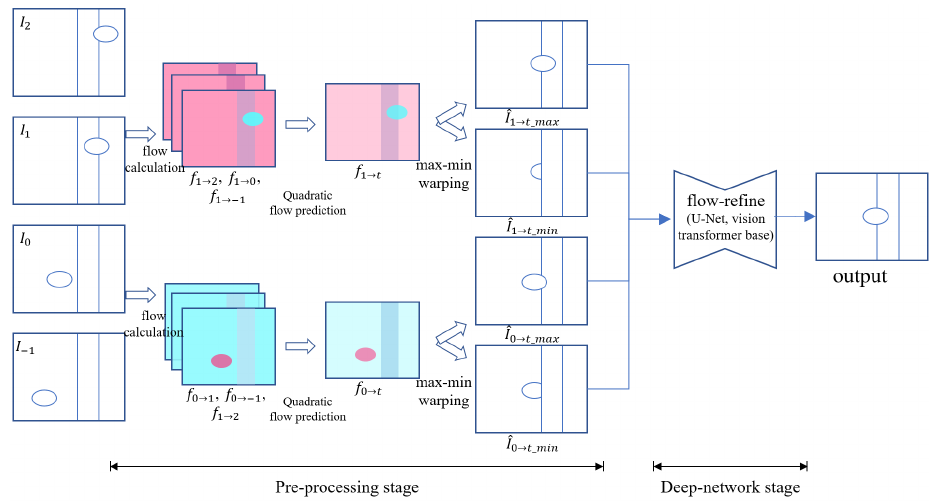
Figure 2. Network overview of the proposed